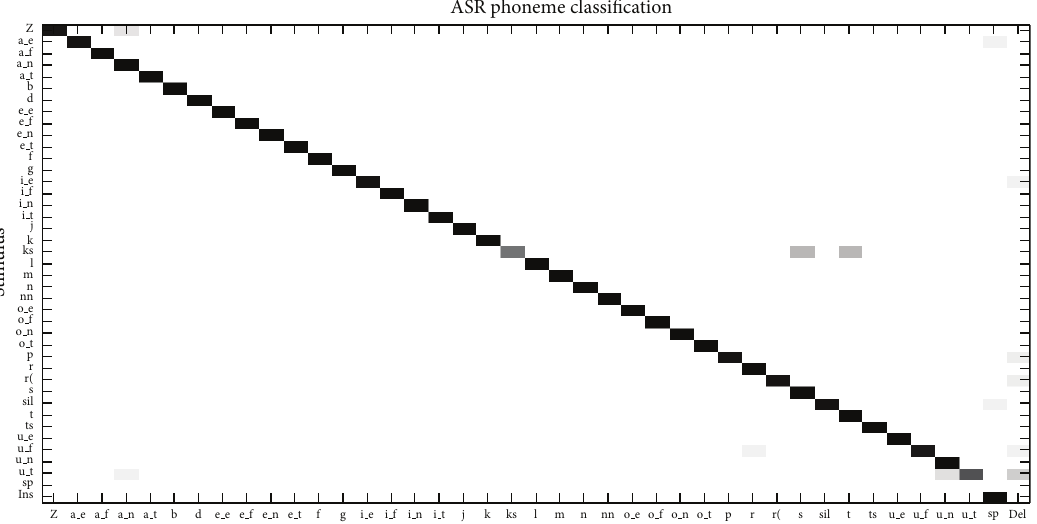
Figure 6: Classification performance of the ASR system for speech recognition on the speech corpus (training = testing set).